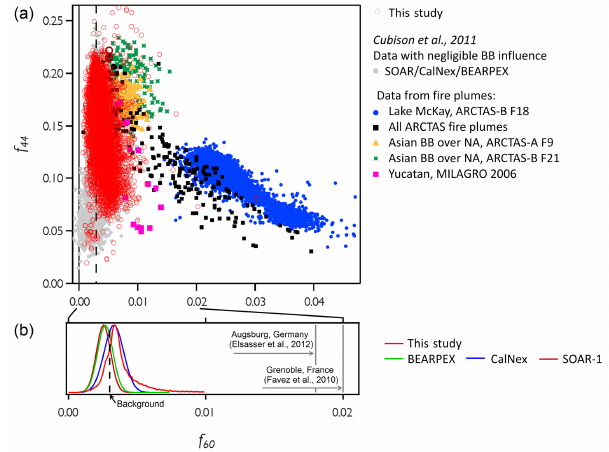
Figure 6. (a) Fraction of the organic fragment at m/z = 44 divided by the total organic mass ( f 44 ) as a function of the fraction of the or- ganic fragment at m/z = 60 divided by the total organic mass ( f 60 ). f 44 and f 60 are commonly used as markers for oxidized organic aerosol and for freshly emitted biomass burning aerosol, respec- tively The red open circles are the data measured during the entire UWFPS. The other symbols show data from previous studies (see Cubison el al., 2011, and references therein), with colored (non-red) points for the biomass burning (BB) plumes and grey points for data with negligible BB influence. The dashed black line corresponds to 0.003, the AMS background value for f 60 . (b) Frequency distribu- tion of f 60 values for this study (light red) and for previous studies with negligible BB influence (green, blue, and dark red lines). The vertical grey solid lines show f 60 values for locations where the influence of wood combustion on organic aerosol was strong.